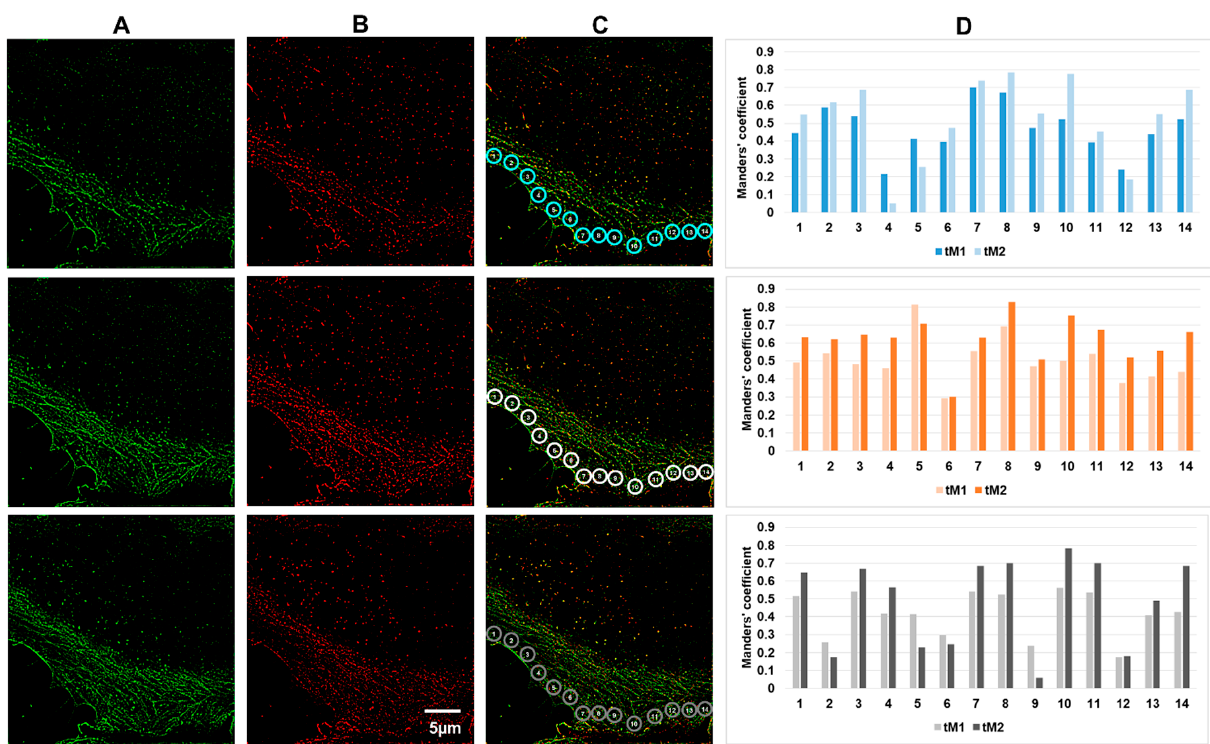
Figure 5. Colocalization of actin filaments in the marginal regions of EA.hy926 cells. Vertical panel ( A ), immunofluorescent staining of β -actin; vertical panel ( B ), immunofluorescent staining of γ -actin; vertical panel ( C ), merged, vertical panel ( D ), three series of fluorescence intensity measurements in successive optical sections in the ROI defined by circles (marked in blue, white and grey) at the cell edge. Measurements of the tM1 and tM2 threshold Manders’ coefficient in three adjacent optical sections are presented. Occasionally, in the adjacent sections for a given ROI, the Manders’ coefficients varied significantly.